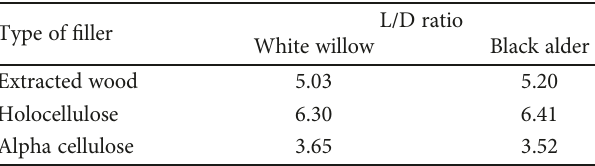
Table 1: L/D ratios of fi